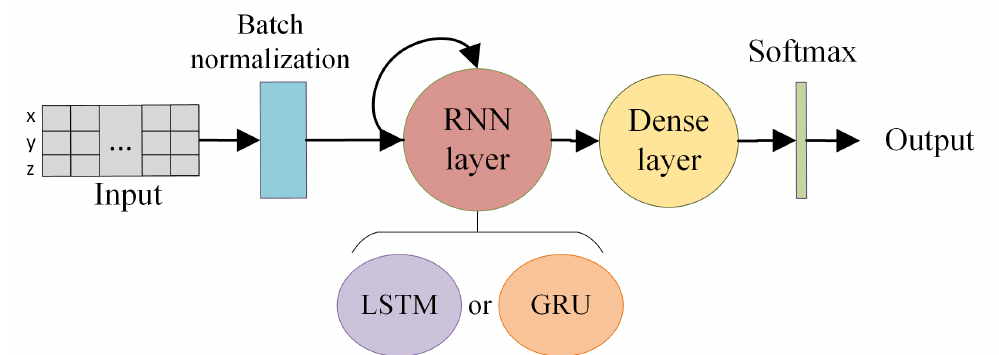
Figure 4. Diagram of the Gated RNN architectures